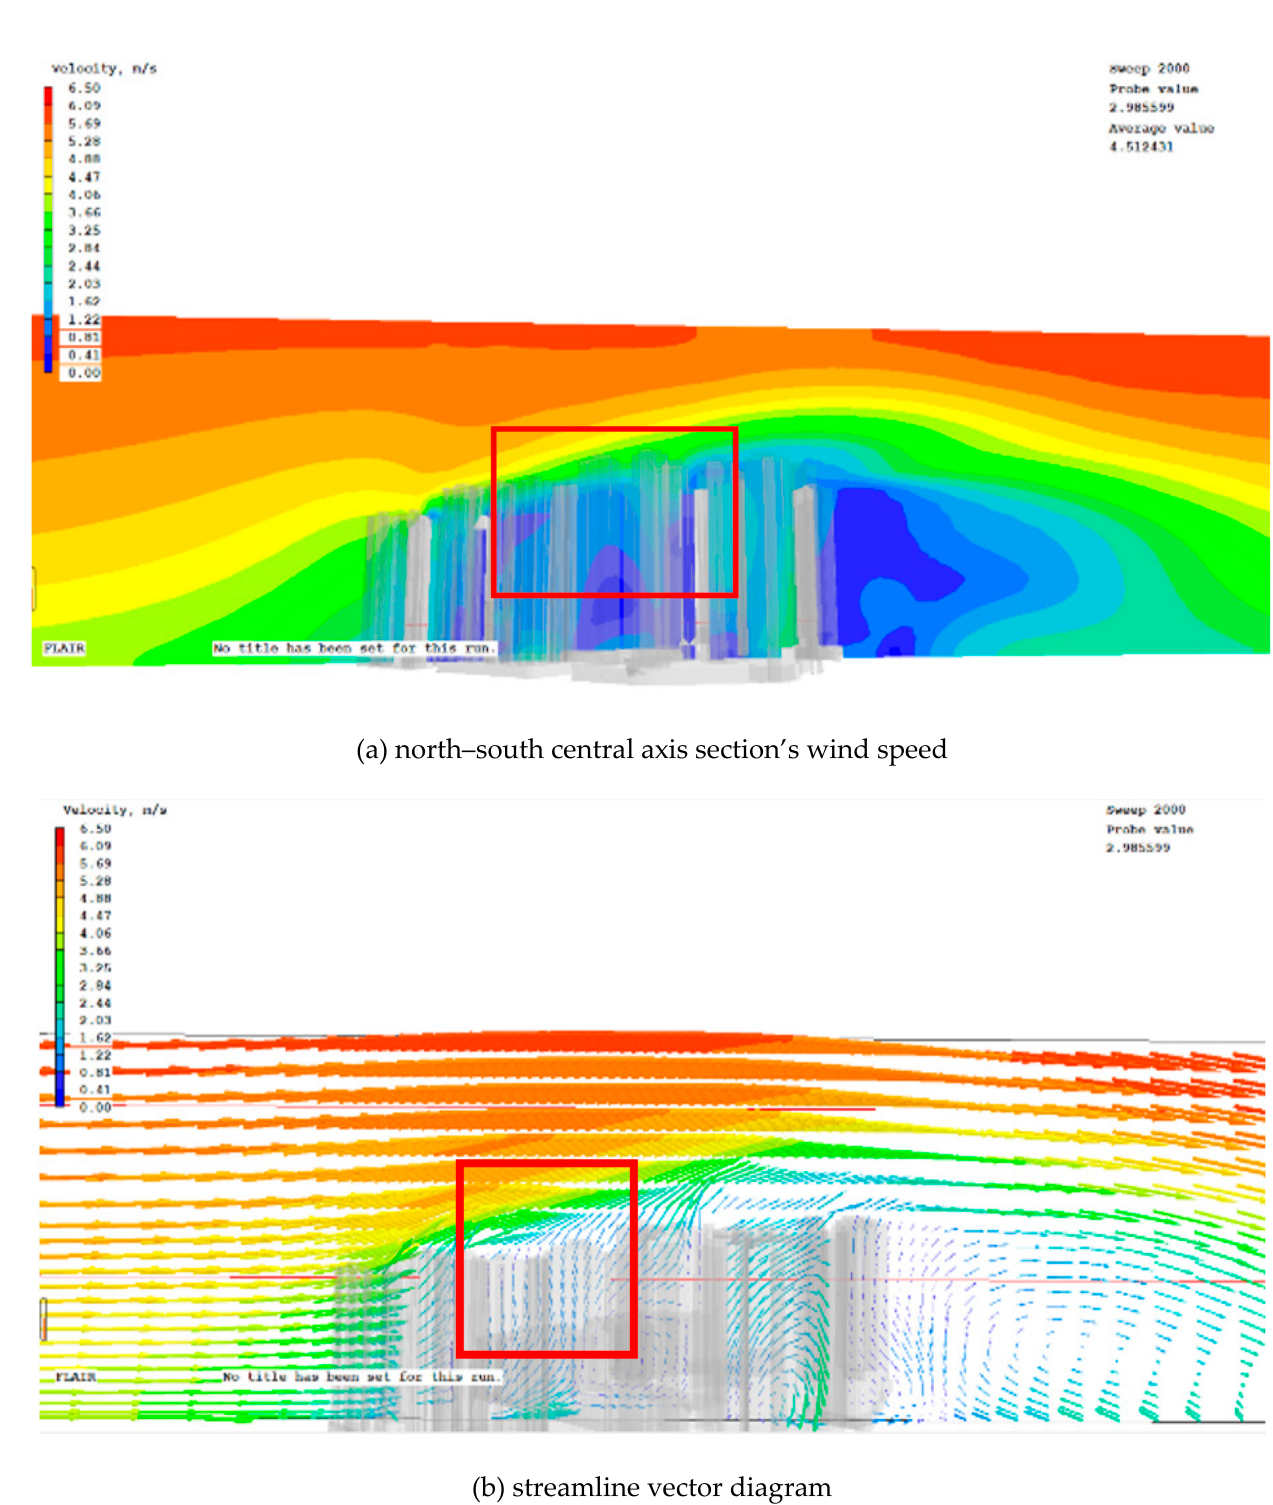
Figure A3. The north–south central axis section’s wind speed and streamline vector diagram in summer.